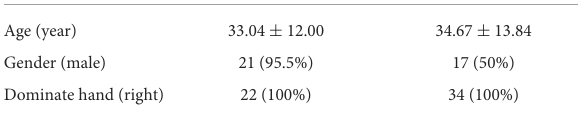
Figure 5. The accuracy, sensitivity, and specificity of rule- based models were (1) 98.2, 91.7, and 99.0% for radial nerve injury detection; (2) 97.3, 83.3% and 99.0% for ulnar nerve injury detection; and (3) 96.4, 87.5, and 97.1% for median nerve injury detection, respectively. In the ML models, radial nerve injury classification achieved the best performance with 100% accuracy. In all classification tasks, the rule-based method maintained sensitivity above 80%. In comparison, lower sensitivity appears in median nerve injury classification, with 62.5% in the SVM and RF models and only 37.5% in the RL model.